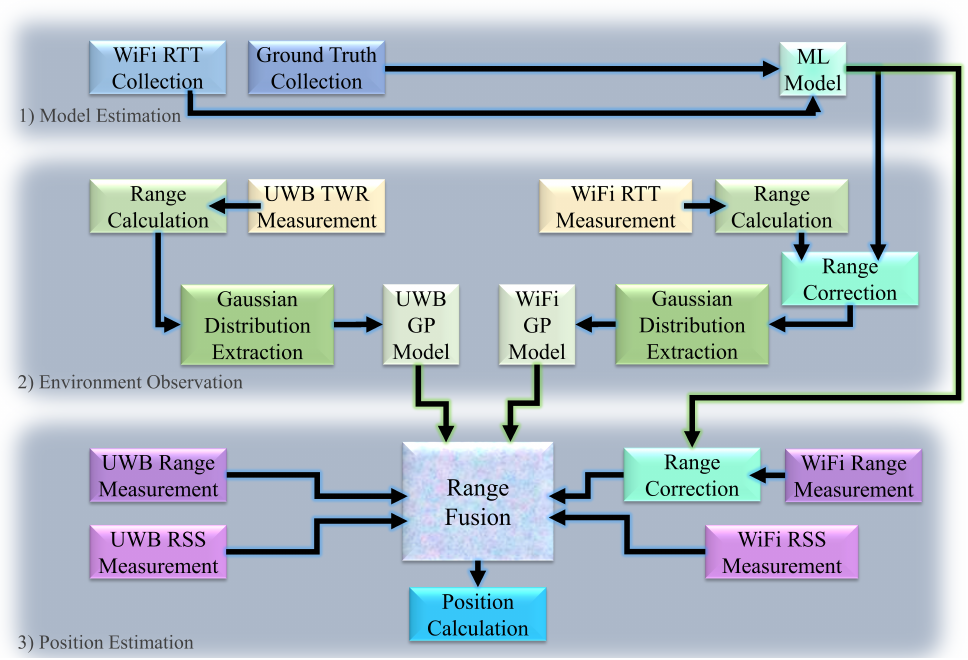
Figure 2. The three phases of the proposed